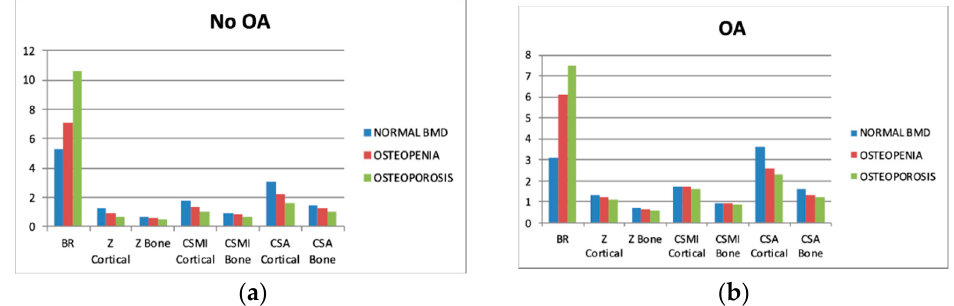
Figure 1. Differences between cross-sectional area (CSA) and biomechanical characteristics, depending on densitometric status—separate graphs for patients with (1b) and without (1a) osteoarthritis (OA). Please refer to “Methods”. Cross-sectional moment of inertia (CSMI).